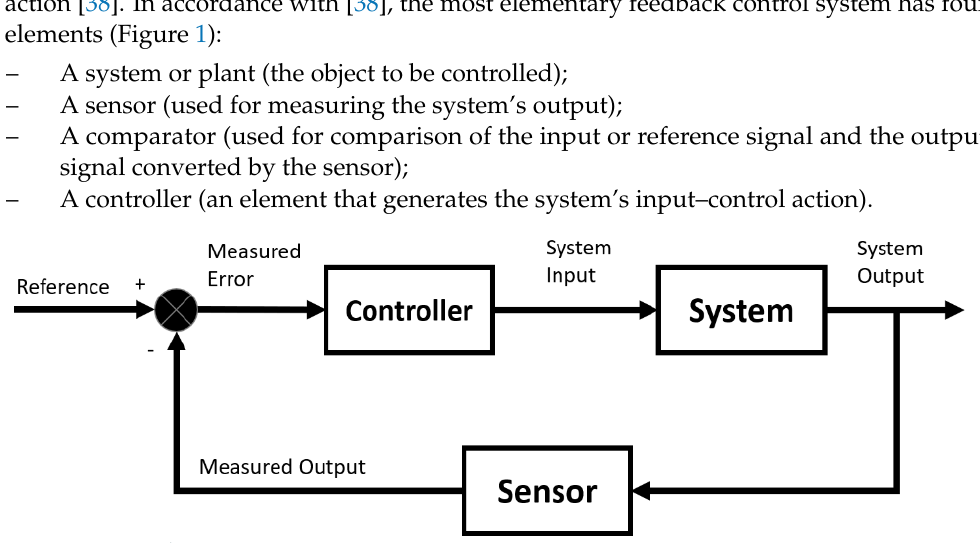
Figure 1. Concept of the feedback loop, reproduced with permission from InstrumentationTools.com, 2021 [38].